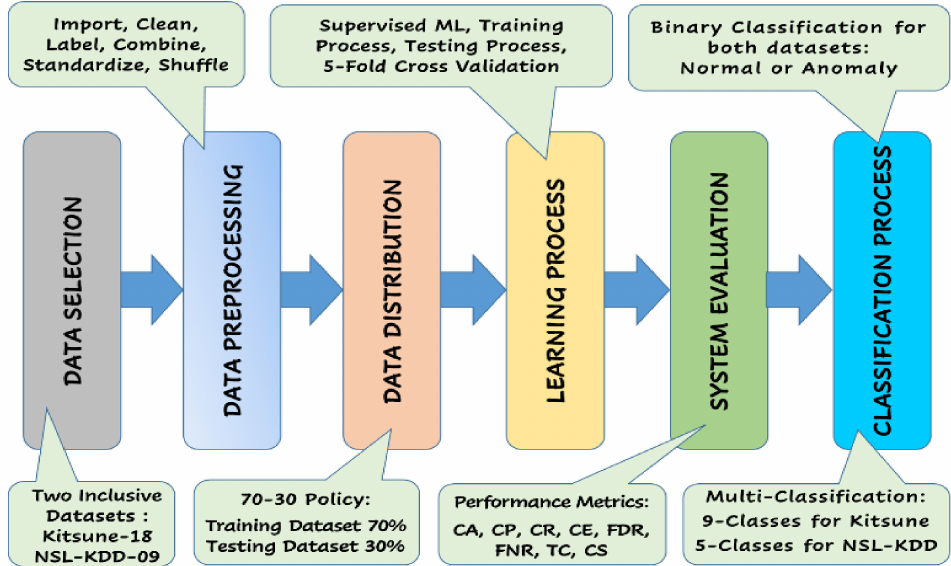
Figure 2. Workflow Diagram for attack-aware IoT network traffic routing via ML